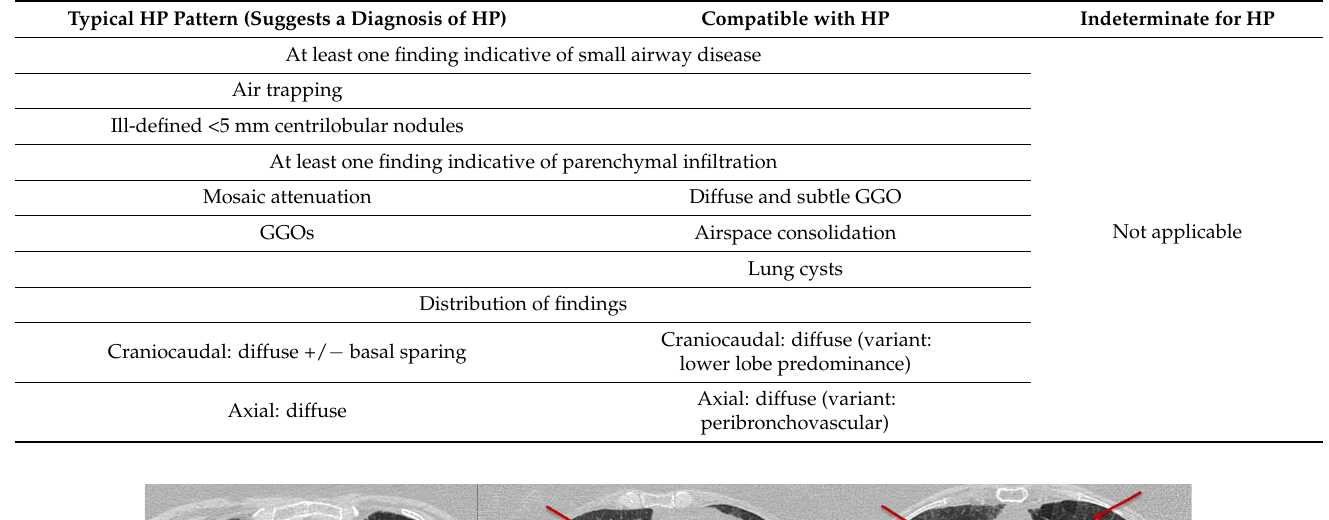
Table 3. Patterns of non-fibrotic HP on chest HRCT scan.